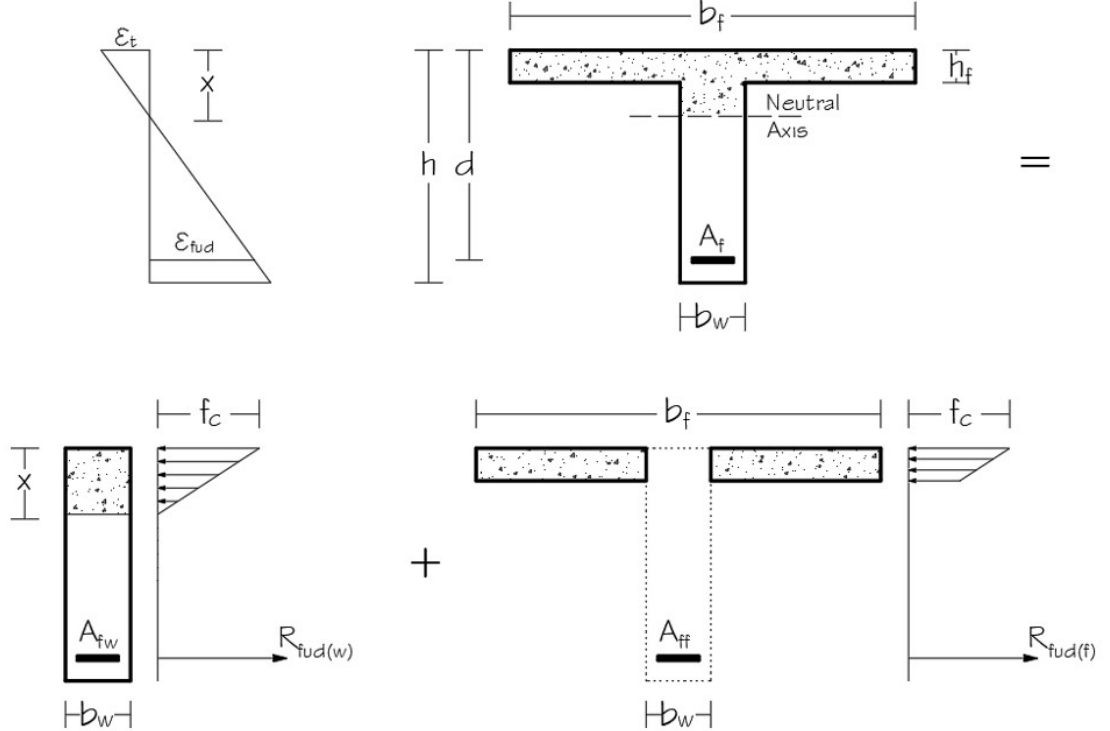
Figure 6. Compatibility and equilibrium of a tension-controlled cross-section for which the concrete linear stress-strain relationship applies